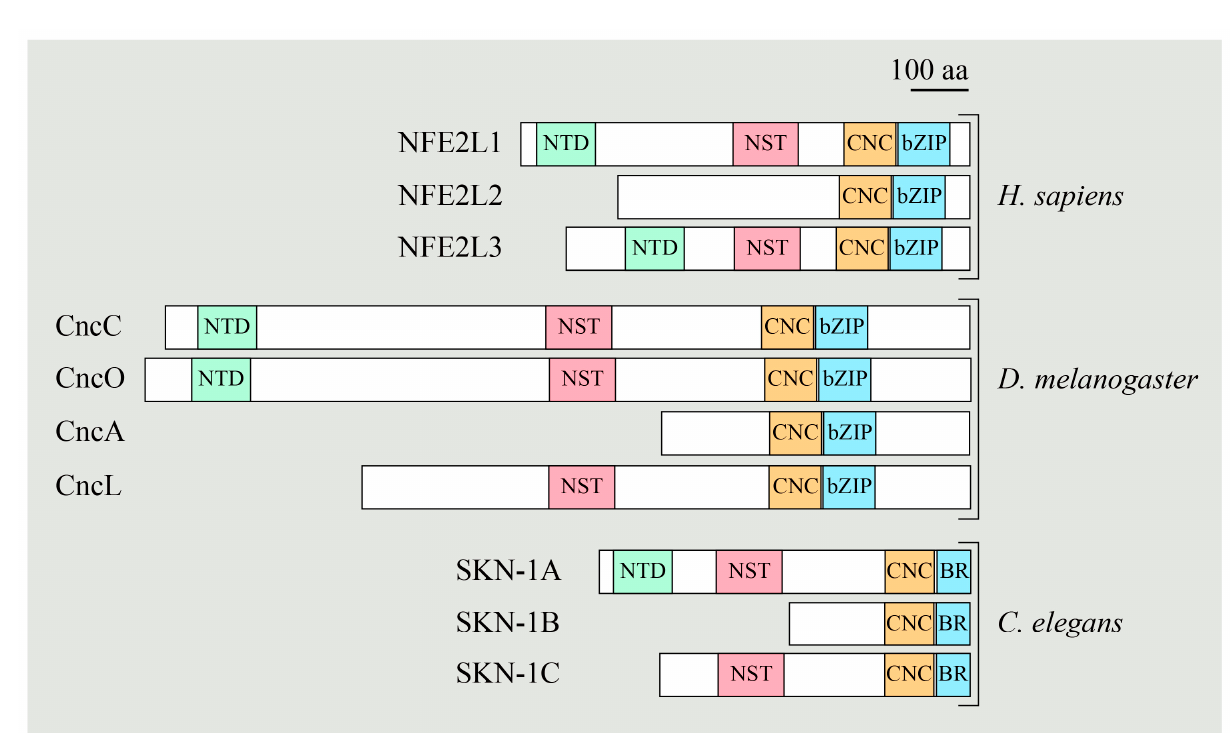
Figure 3. Schematic representation of the cap ’n’ collar proteins in the indicated species. Note that only representative isoforms of the fly cap ’n’ collar are shown. aa, amino acid; NTD, N-terminal domain; NST, Asn/Ser/Thr-rich domain; CNC, cap ’n’ collar; bZIP, basic leucine zipper; BR, basic region.